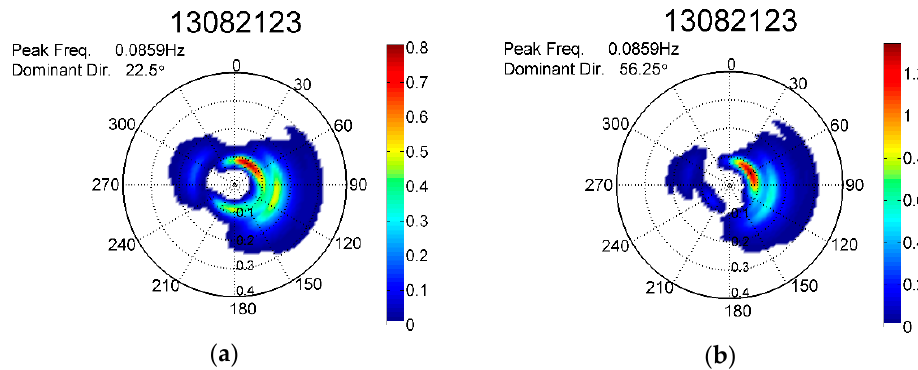
Figure 13. Directional wave spectra obtained at 23:00 on 21 August 2013 from the ( a ) ATC sensor and ( b ) GNSS buoy.